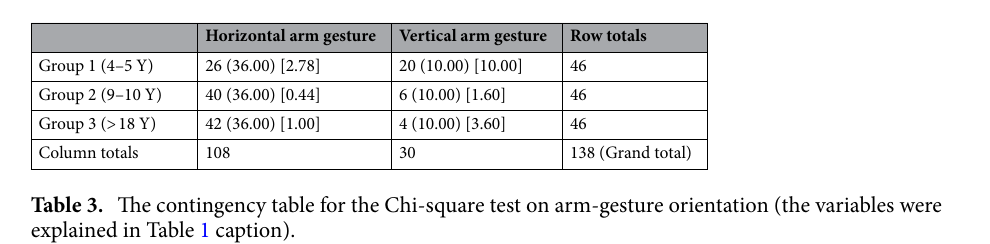
Figure 2. The number of subjects estimated one or the other type of videos as longer in duration by different age groups (pre-kindergarteners, school-age children, and adults).